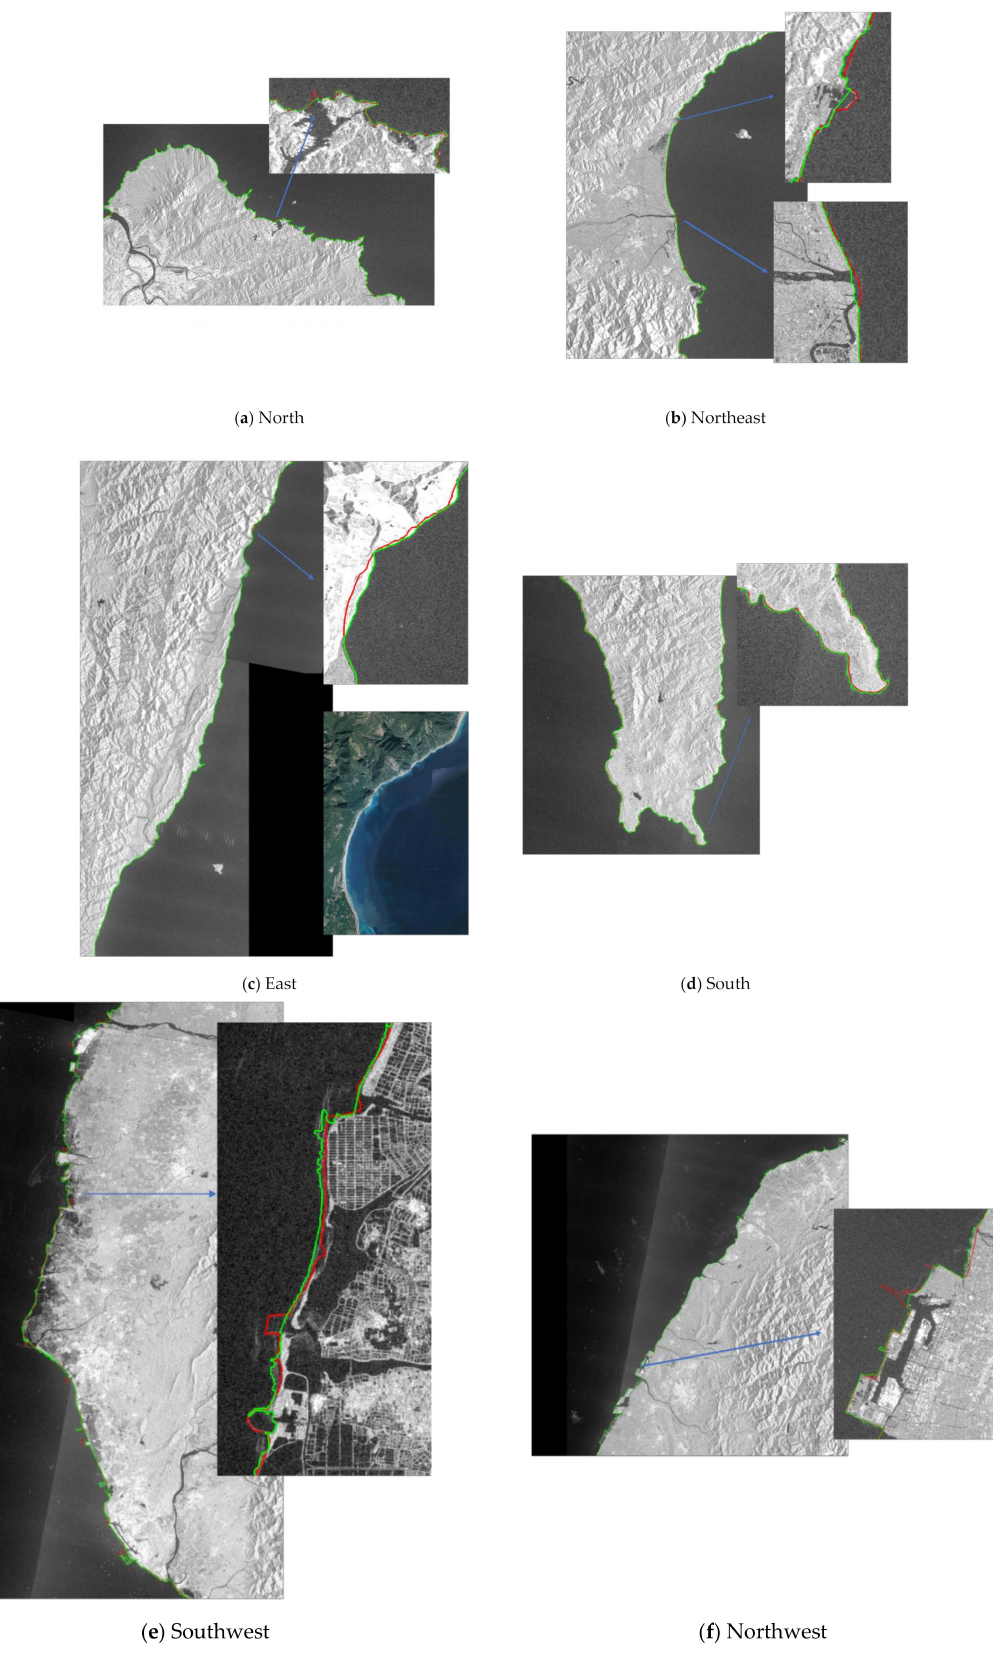
Figure 12. Shoreline detection results for different regions of Taiwan. The red border represents the ground truth data. The green border represents the detection results from the proposed